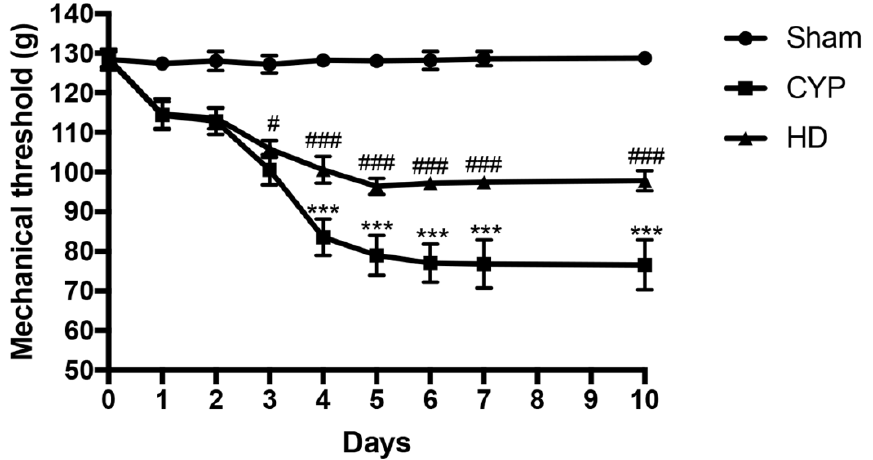
Figure 8. Effect of HD on mechanical allodynia in CYP-injected mice. Mechanical allodynia was evaluated by von Frey test. Values are means ± SD of five animals for each group; *** p < 0.001 vs. Sham; # p < 0.05 vs. CYP; ### p < 0.001 vs. CYP.